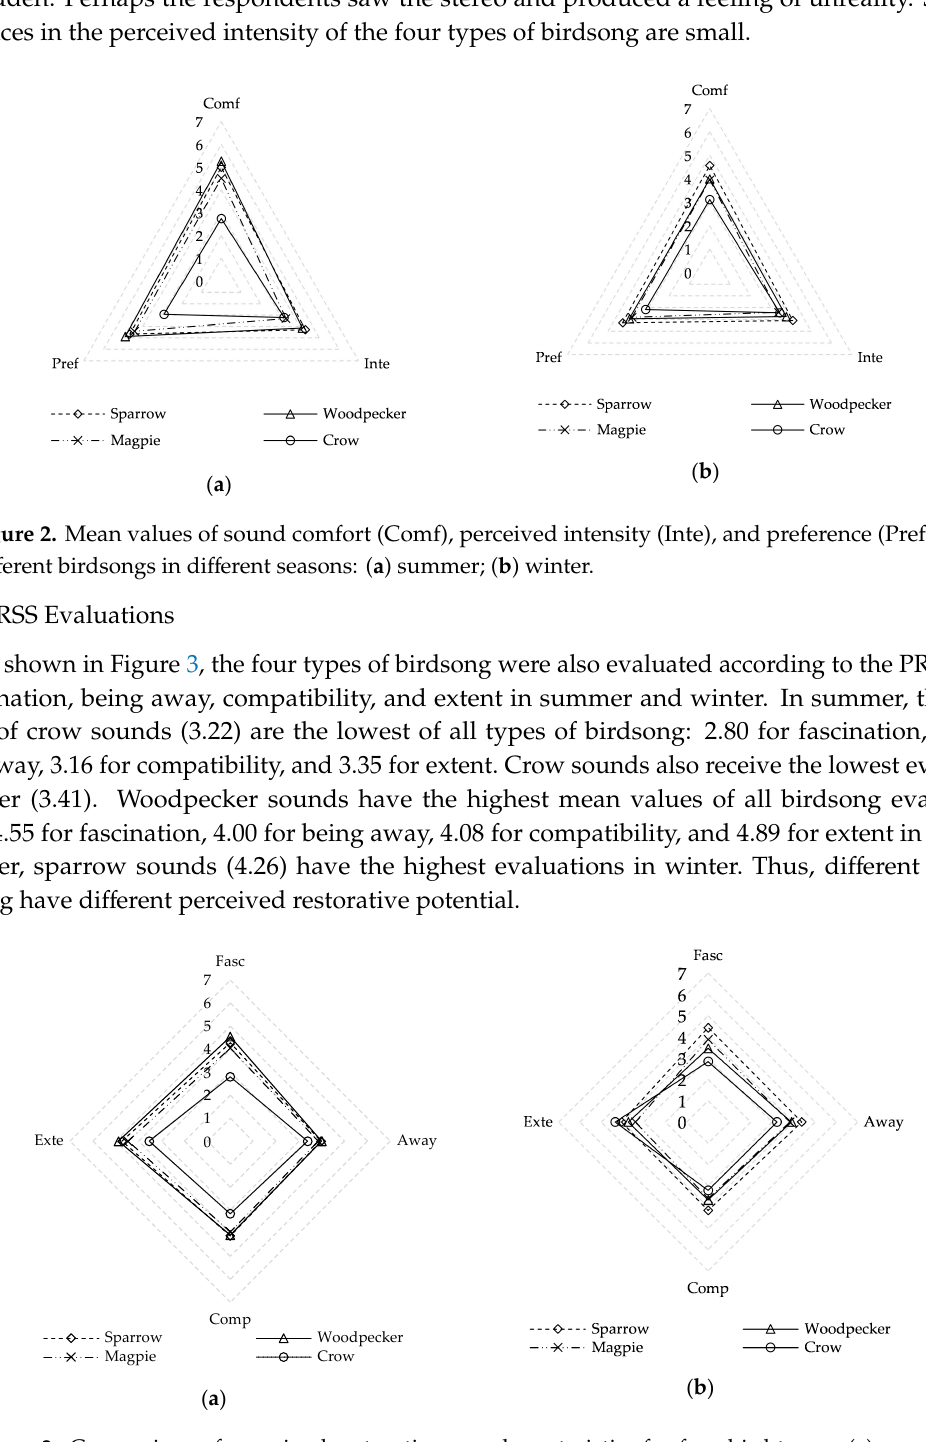
Figure 3. Comparison of perceived restorativeness characteristics for four bird types: ( a ) summer; ( b ) winter. Fasc = fascination; Away = being away; Comp = compatibility, and Exte = extent.